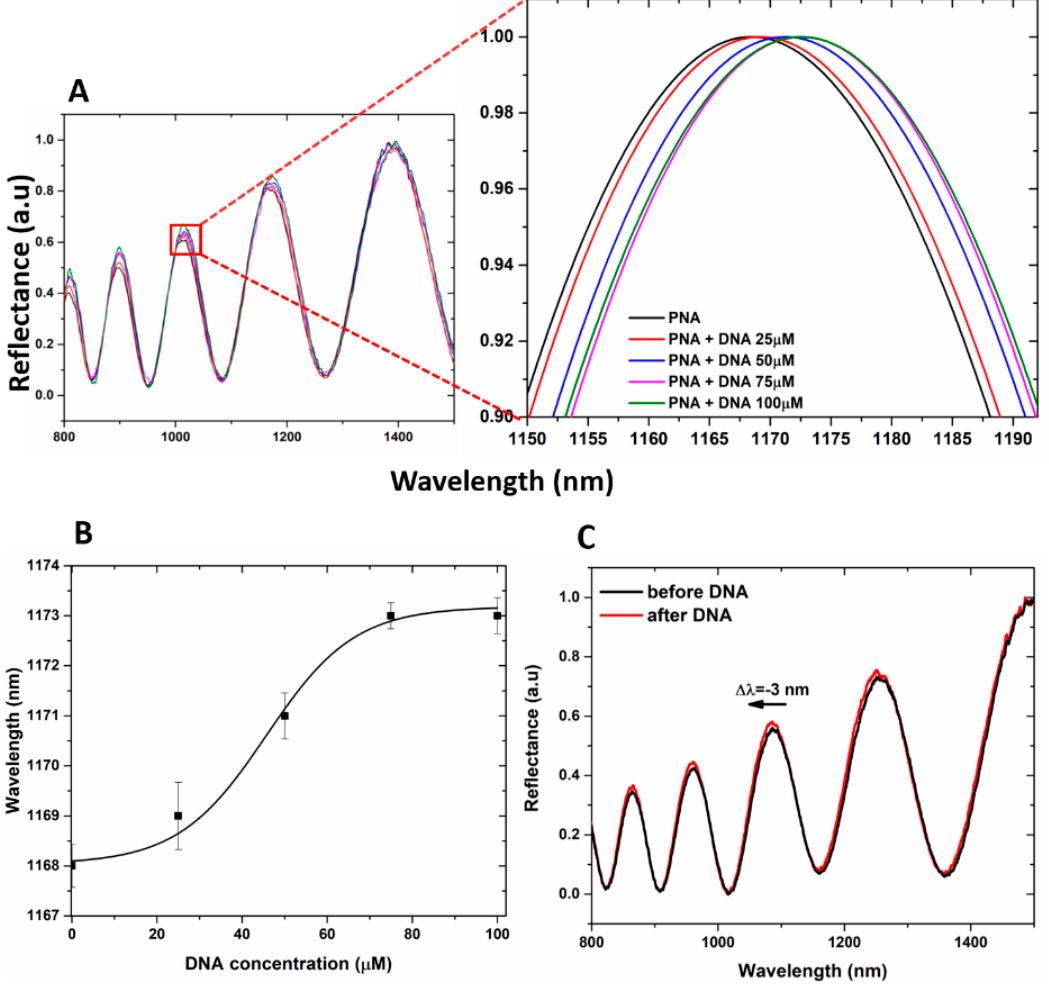
Figure 6. ( A ) reflectivity spectra of PNA-GO/PSi device after the DNA incubation at pH 5. ( B ) dose–response curve as a function of the DNA concentration (pH 5). Experimental data (black squares) were fitted by using OriginLab TM Dose–response nonlinear curve fit. ( C ) reflectivity spectra of PNA-GO/PSi device after the DNA incubation at pH 7.5.